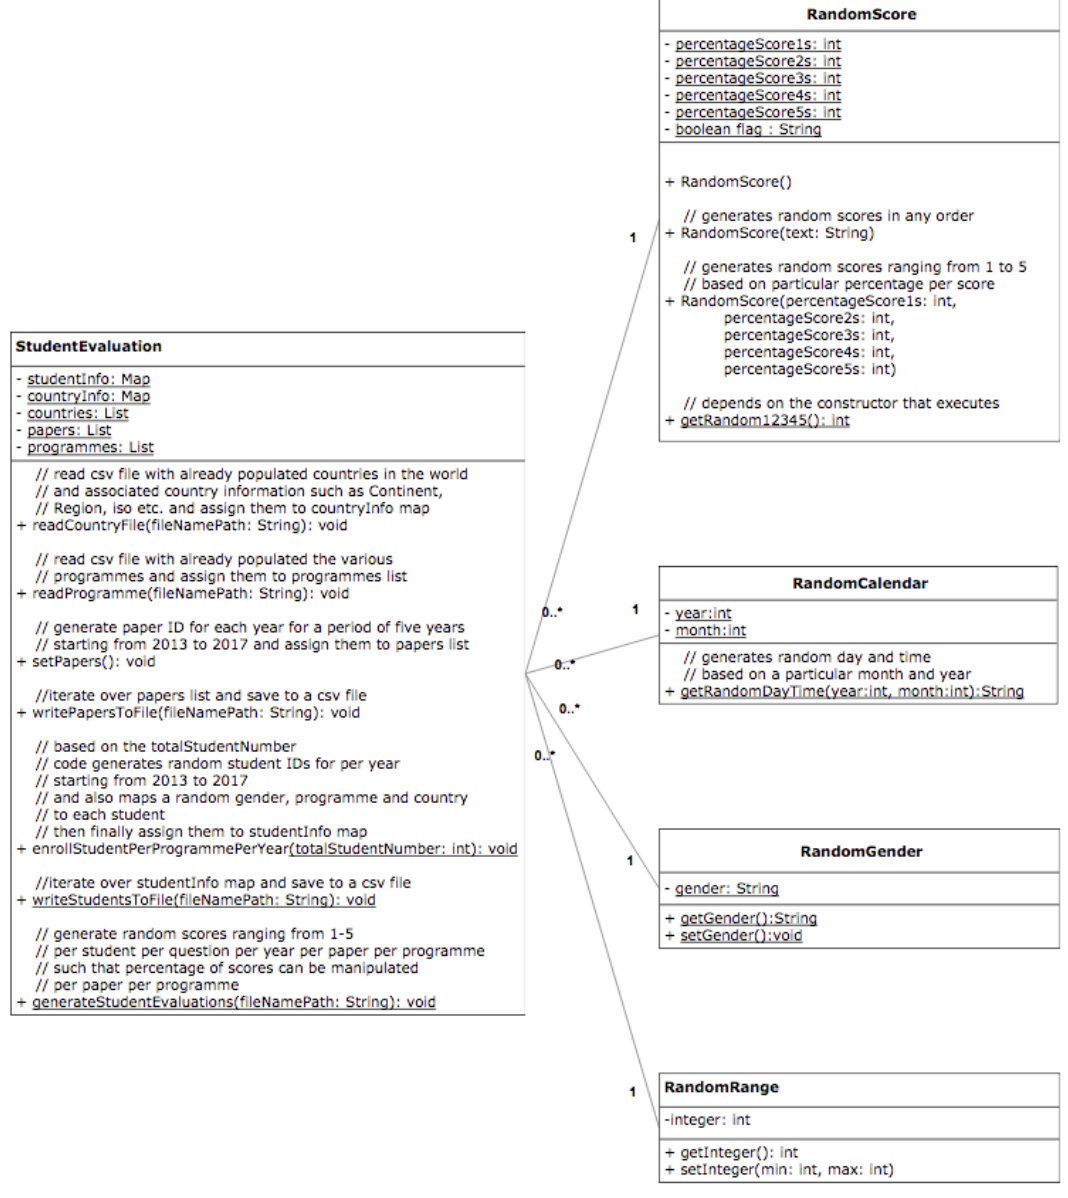
Figure 4. UML diagram of classes that simulated evaluation